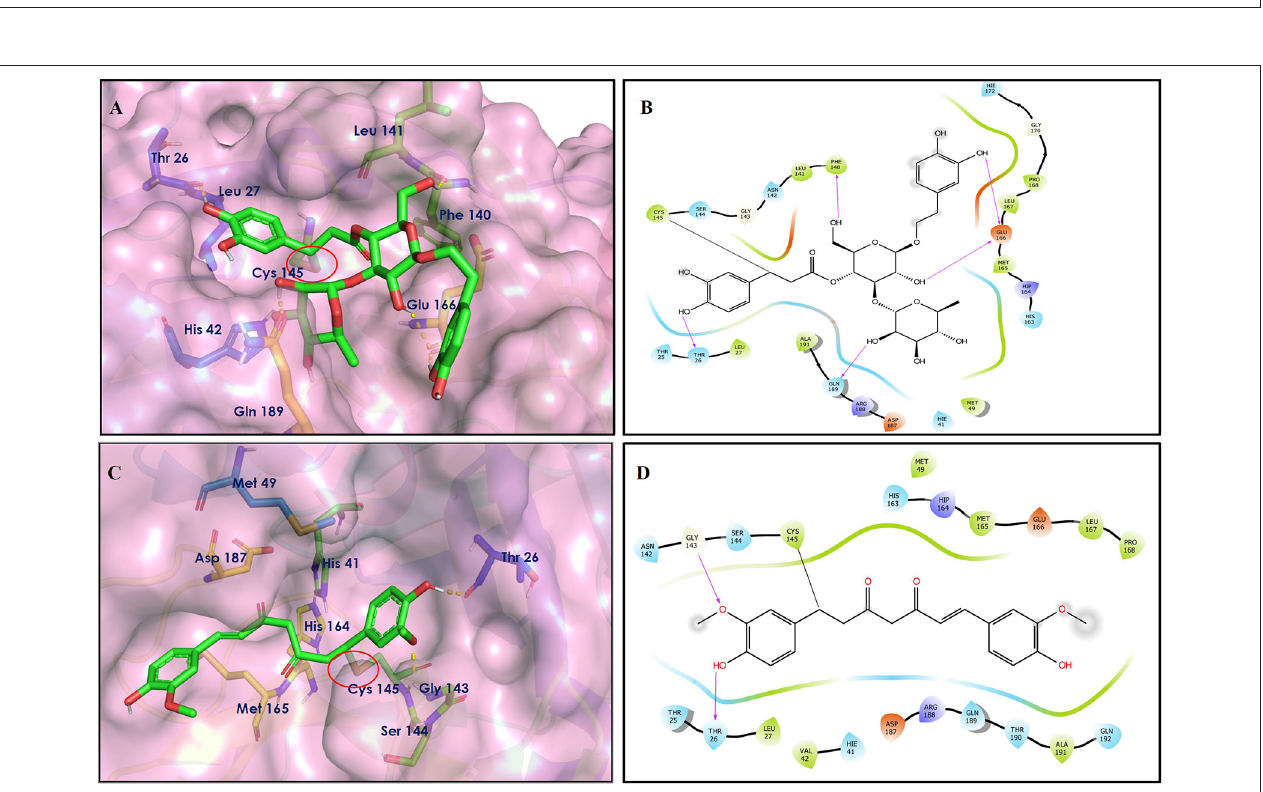
FIGURE 6 | Covalent docking interactions of compounds (2, 42: A–D) in the active sites of Mpro. (A,C) 3D-Binding mode of compounds 2 and 42 with Mpro active site, respectively. Ligands are shown as green sticks, Mpro residues are shown as atom type color sticks, hydrogen bonds formed between ligands and receptor are depicted as yellow dotted lines, the red circle highlights the C–S covalent bond. (B,D) 2D-ligand interaction diagram of compounds 2 and 42 with Mpro active site, respectively.